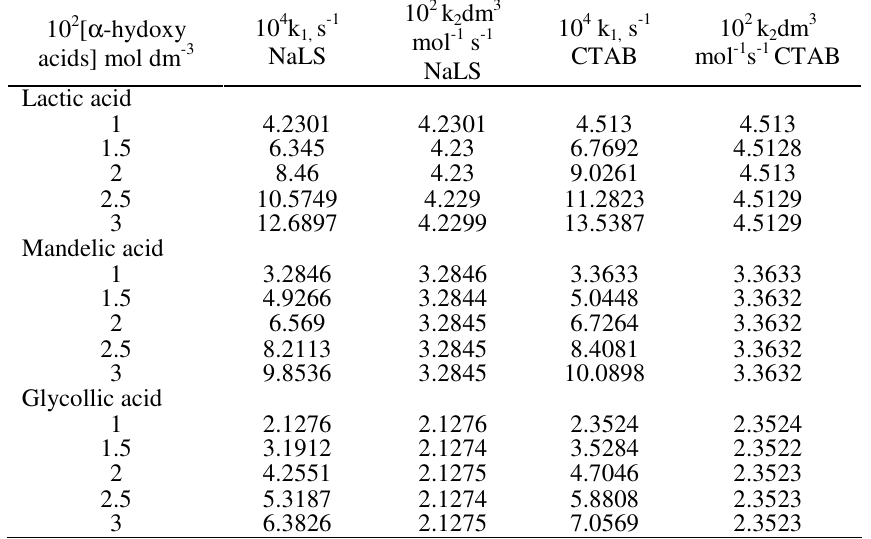
Table 3. First order rate constants for PFC oxidation of α -hydroxy acids at 35±0.2 0